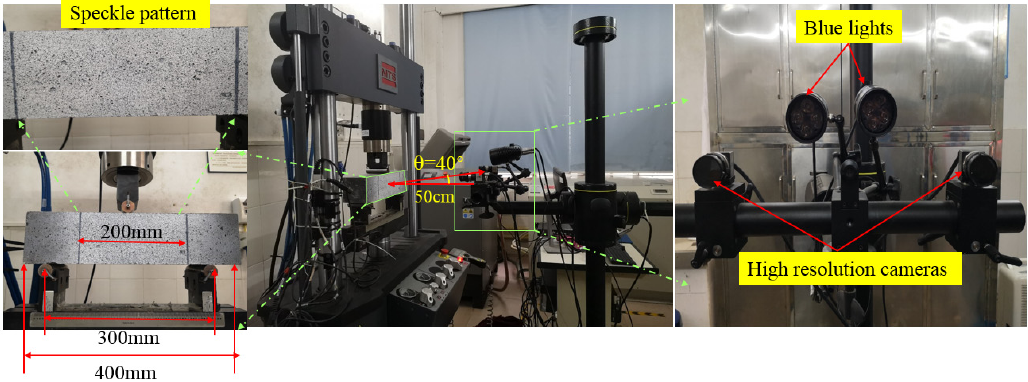
Figure 3. Components and application of DIC technique.